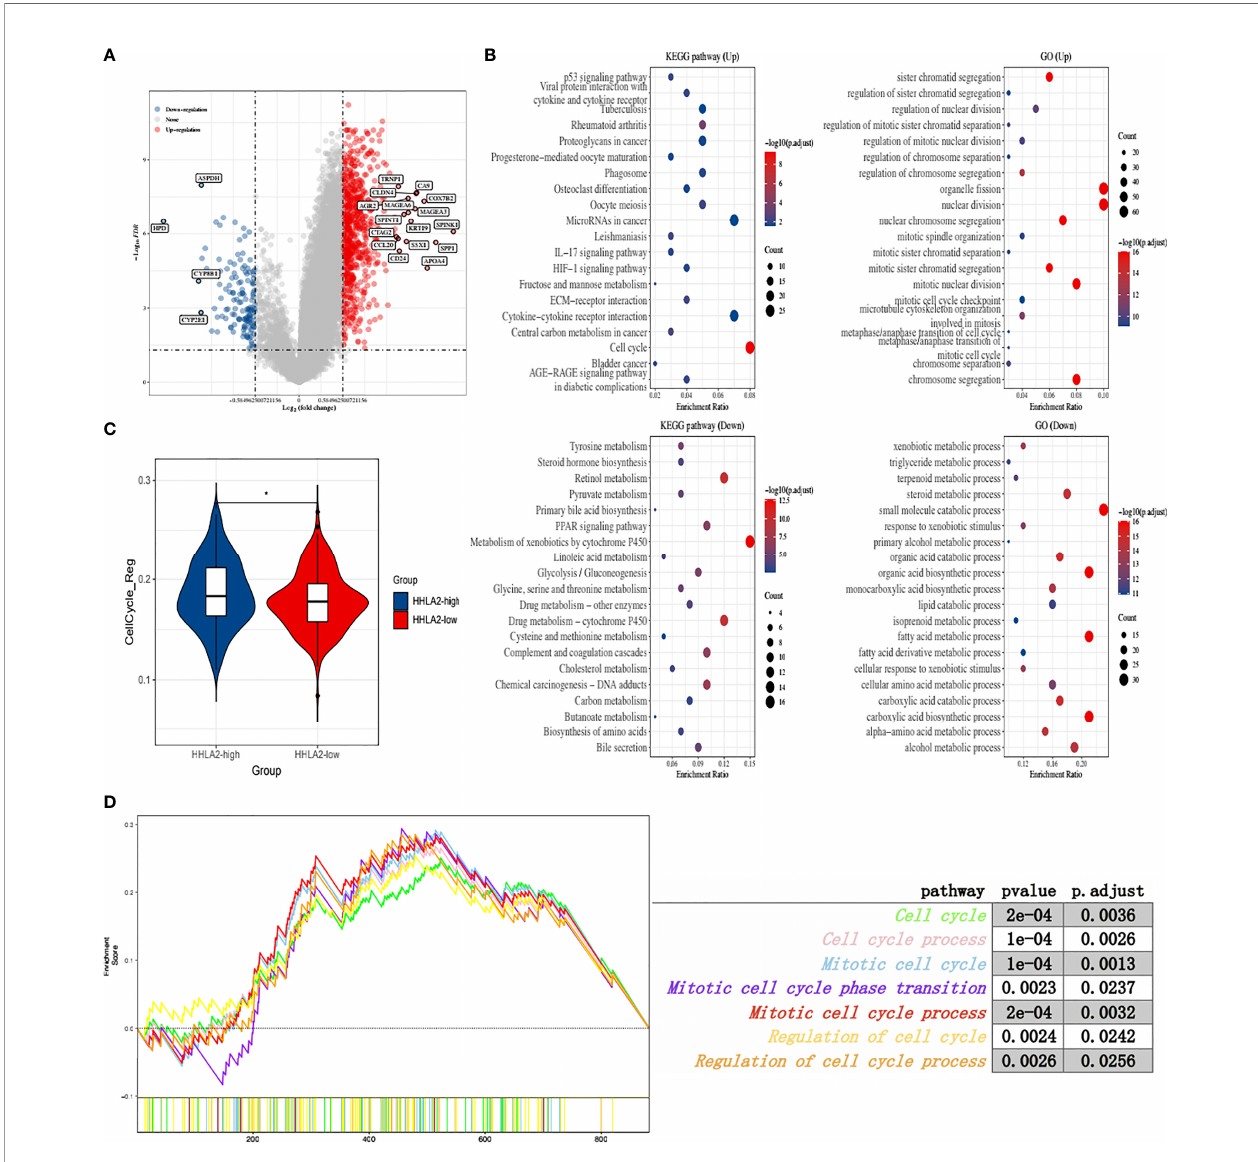
FIGURE 2 | Function analyses of HHLA2 expression. (A) Enhanced volcano plot of differential genes between HHLA2-high and HHLA2-low subgroups. (B) Functional enrichment analyses by GO and KEGG. (C) Comparison of cell cycle regulation signature between HHLA2-high and HHLA2-low subgroups. (D) MultiGSEA plot of related cell-cycle pathways. *p <